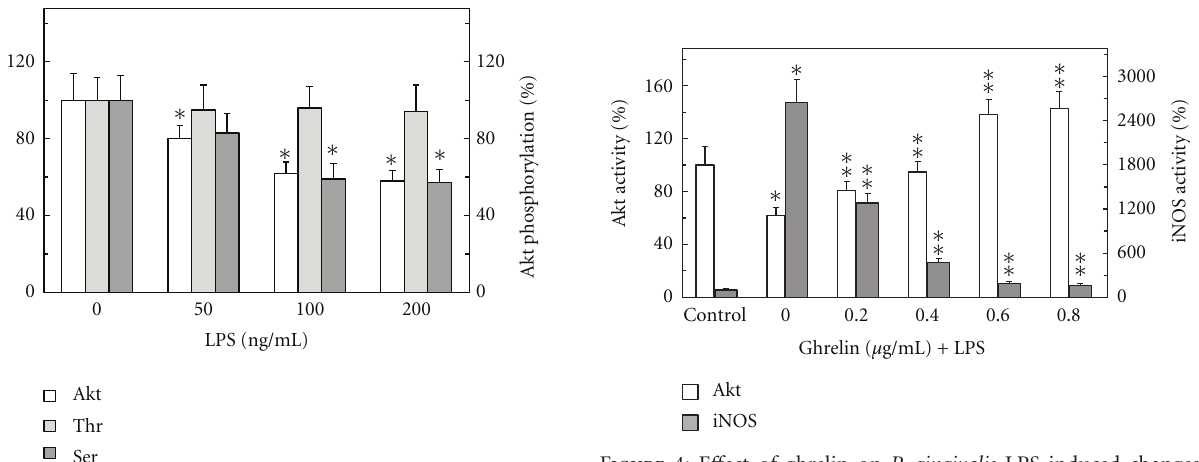
Figure 4: E ff ect of ghrelin on P. gingivalis LPS-induced changes in the expression of Akt kinase and iNOS activities in the salivary gland acinar cells. The cells, preincubated with the indicated concentrations of ghrelin, were treated with the LPS at 100ng/mL and incubated for 16h. Values represent the means ± SD of five experiments. ∗ P < . 5 compared with that of control. ∗∗ P < . 05 compared with that of LPS